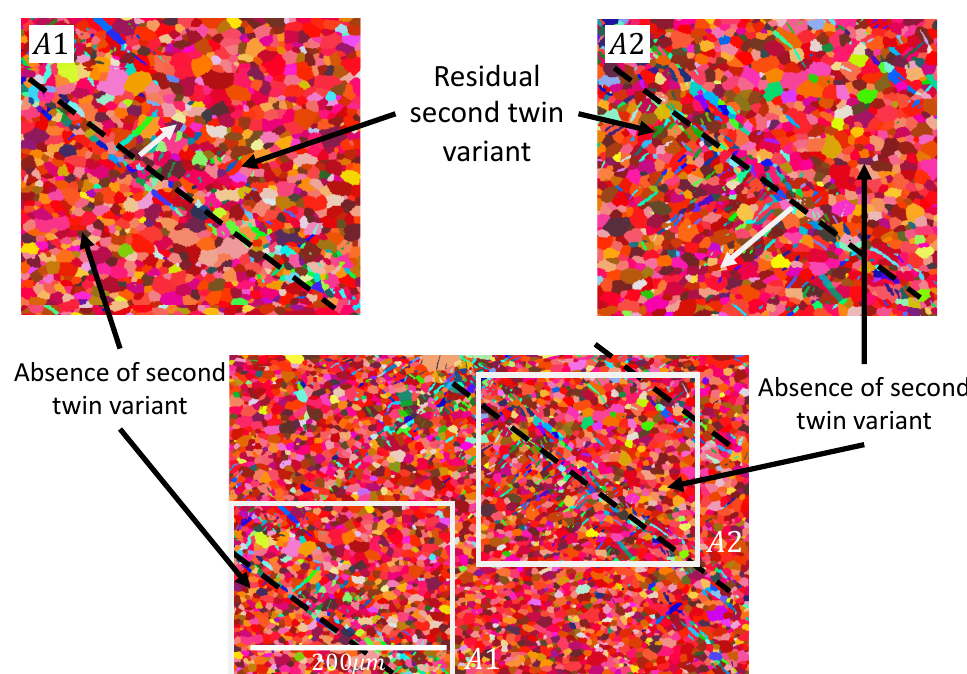
Figure 20. The microstructure showing the growth of second twin variants, along the direction shown by white lines, in-between initial twin bands (shown by dashed black lines) and traces of residual second twin variant on areas A1 and A2 featuring pseudo-elasticity and twin–twin interactions, reproduced from [233], with permission from Elsevier